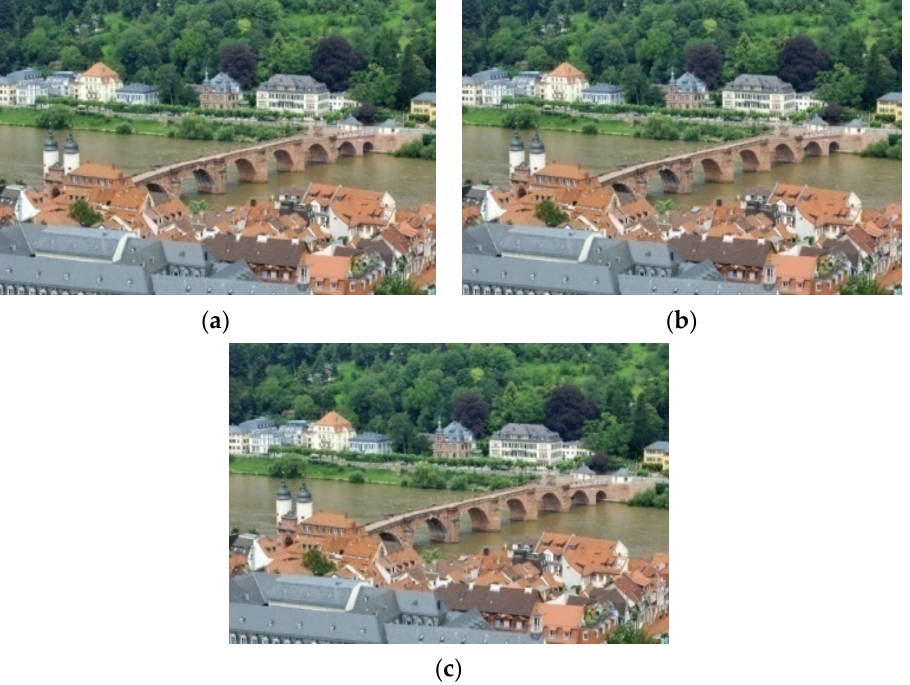
Figure 2. Comparisons of image quality with conventional dimming. ( a ) Max pixel (PSNR: 51); ( b ) 95% pixel count (PSNR: 42); ( c ) Histogram weighted average (PSNR: 24).